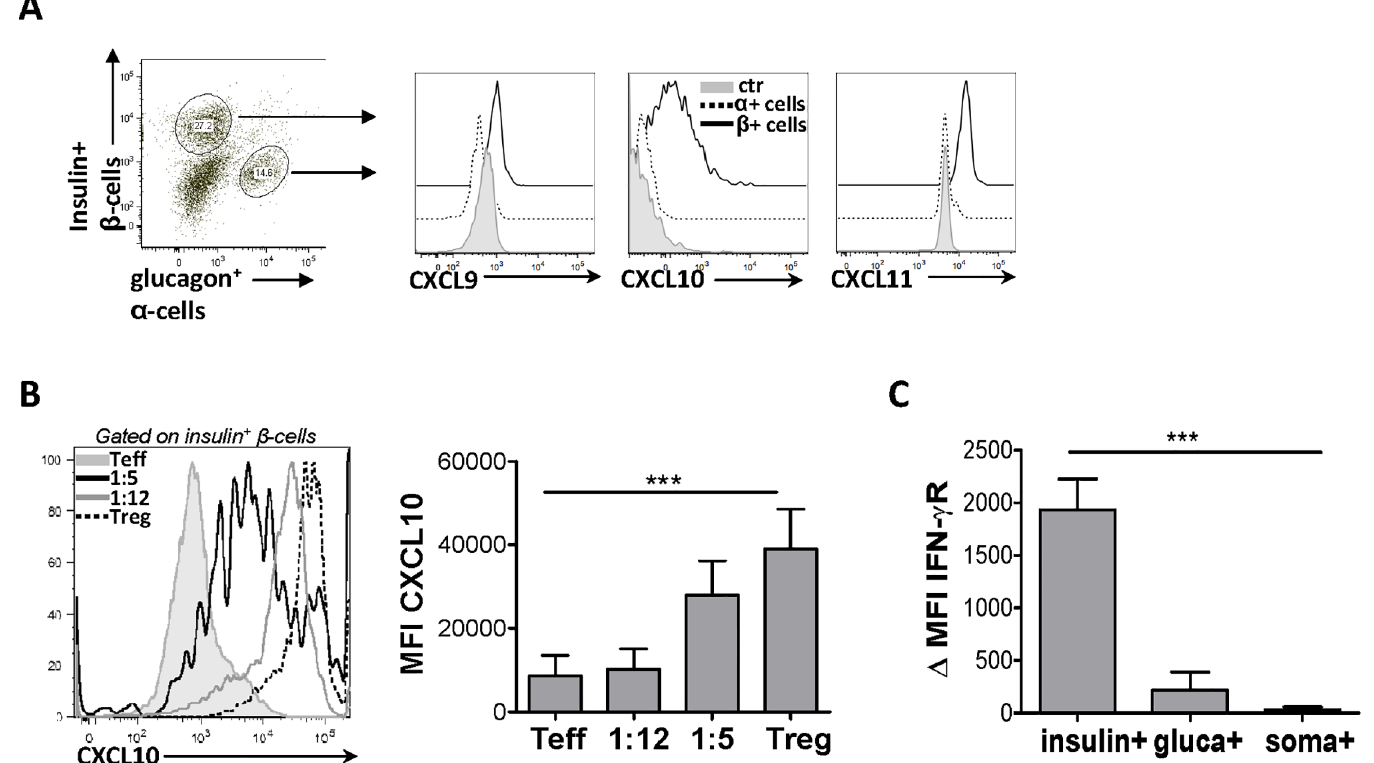
Fig 5. Intra-islet T reg cells reverse T eff cell-mediated abrogation of chemokine secretion by ß-islet cells. β -islet cells were isolated from 4-week-old BDC2.5 mice. (A) Expression of CXCR3 chemokines was compared between insulin + cells and glucagon + cells, and unstained controls. (B), NOD.TCR α -/- mice received T reg or T eff cells either alone or at the indicated T reg/ T eff cell ratios. When mice receiving T eff cells alone became hyperglycemic ( > 33mmol/L), CXCL10 expression (MFI) in β -islet cells was compared between groups. (C) IFN- γ R Δ MFI ( Δ MFI was calculated by subtracting the isotype control MFI from IFN- γ R antibody MFI) and was compared between β (insulin + ), α (glucagon + ) and δ (somatostatin + ) cells isolated from 4-week-old BDC2.5 mice. (5B, 5C n =